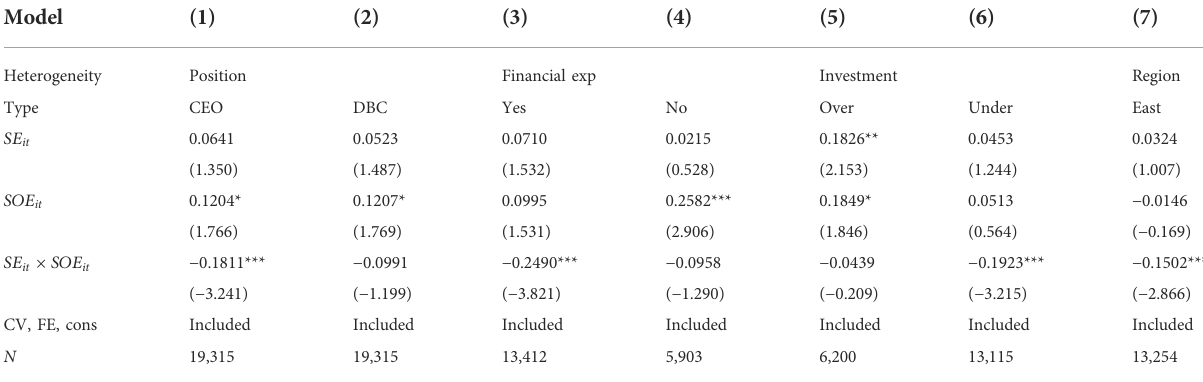
TABLE 6 Results of considering heterogeneity.